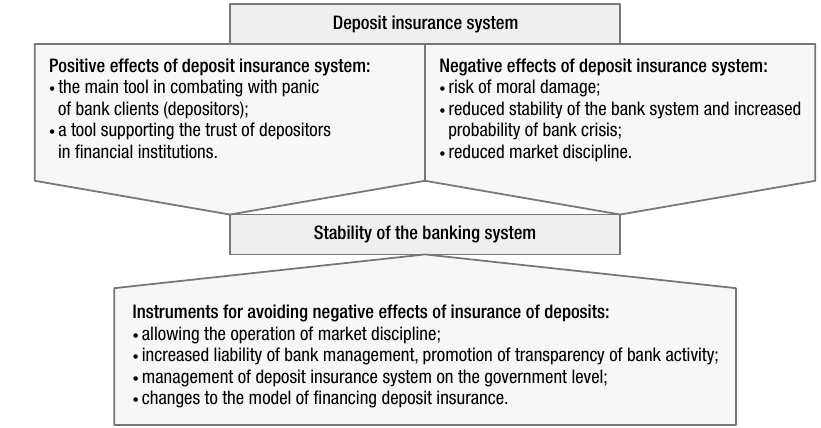
Fig. 1. The in (cid:192) uence of the system of deposit insurance on the stability of the banking system (Maysami, Lim 2004; Demirguc-Kunt, Detragiache 2000; Drehmann 2002; Ioannidou de Dreu 2006; Santomero 1997; Demirguc-Kunt, Kane 2002; Schich 2008)